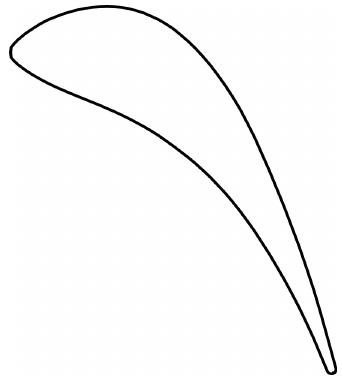
Figure 4. VKI turbine blade profile.